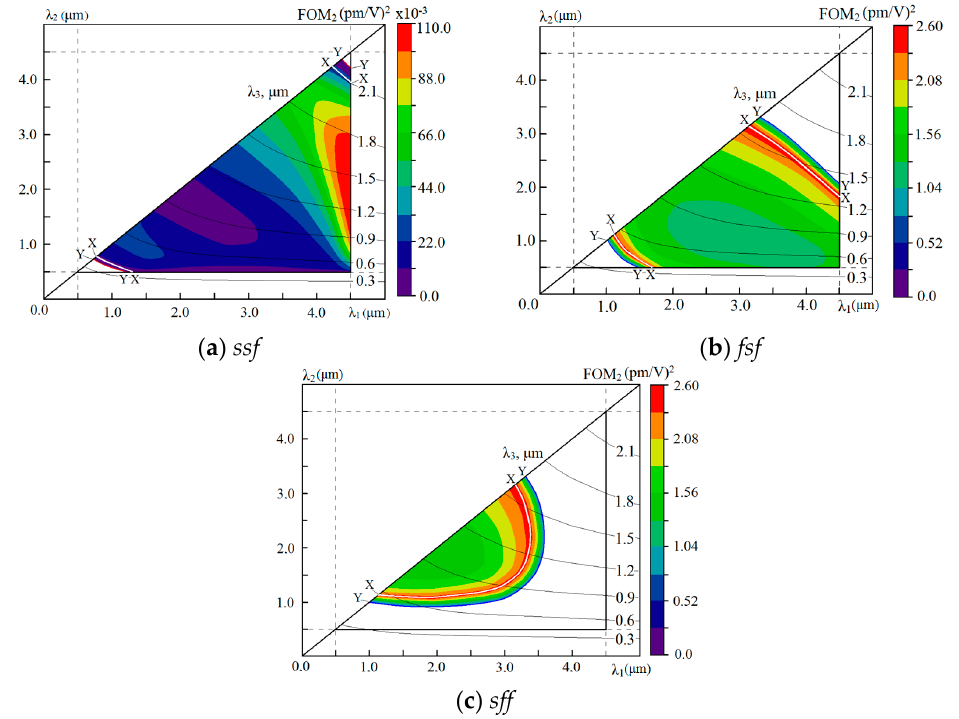
Figure 2. FOM D ( λ 1 , λ 2 ) distributions for KTP crystal for all types of interactions: ( a ) ssf , ( b ) fsf , ( c ) sff .